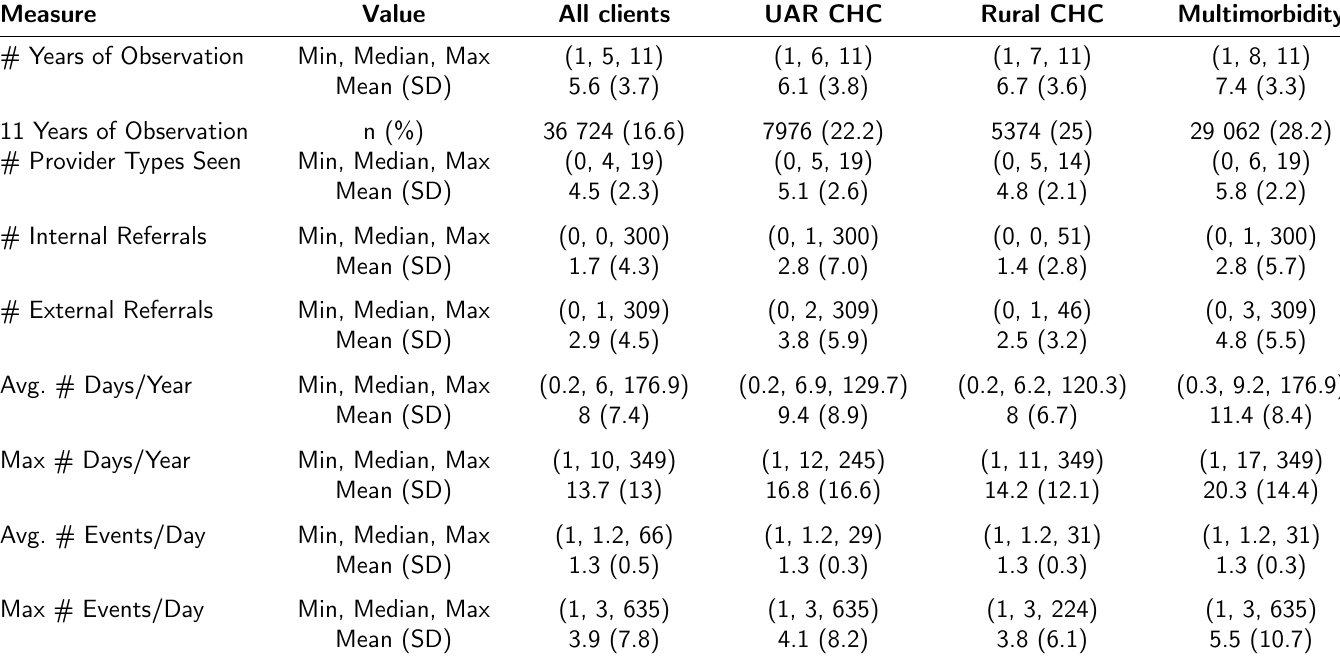
Supplementary Table 3: Health care use characteristics